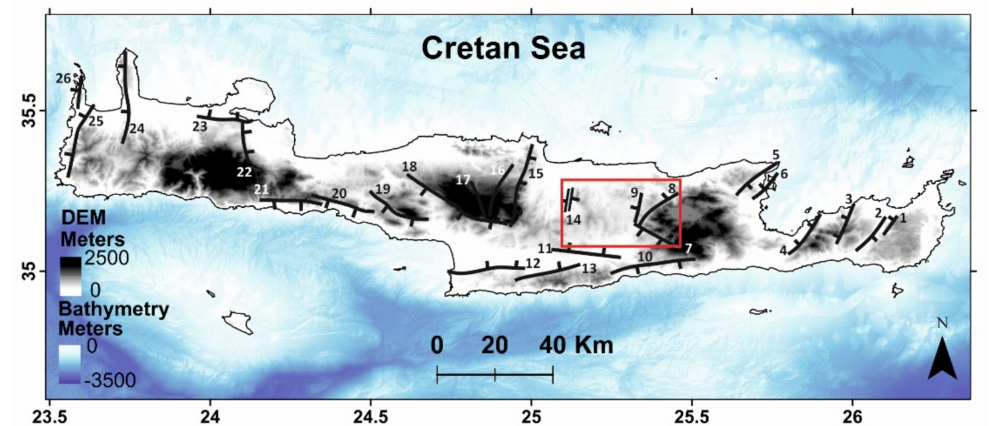
Figure 3. Simplified map of 26 active faults identified on Crete from several sources (see text in Section 2.1) dashes on downthrown side. Key: rectangle indicates the study area shown in Figure 4; 1: